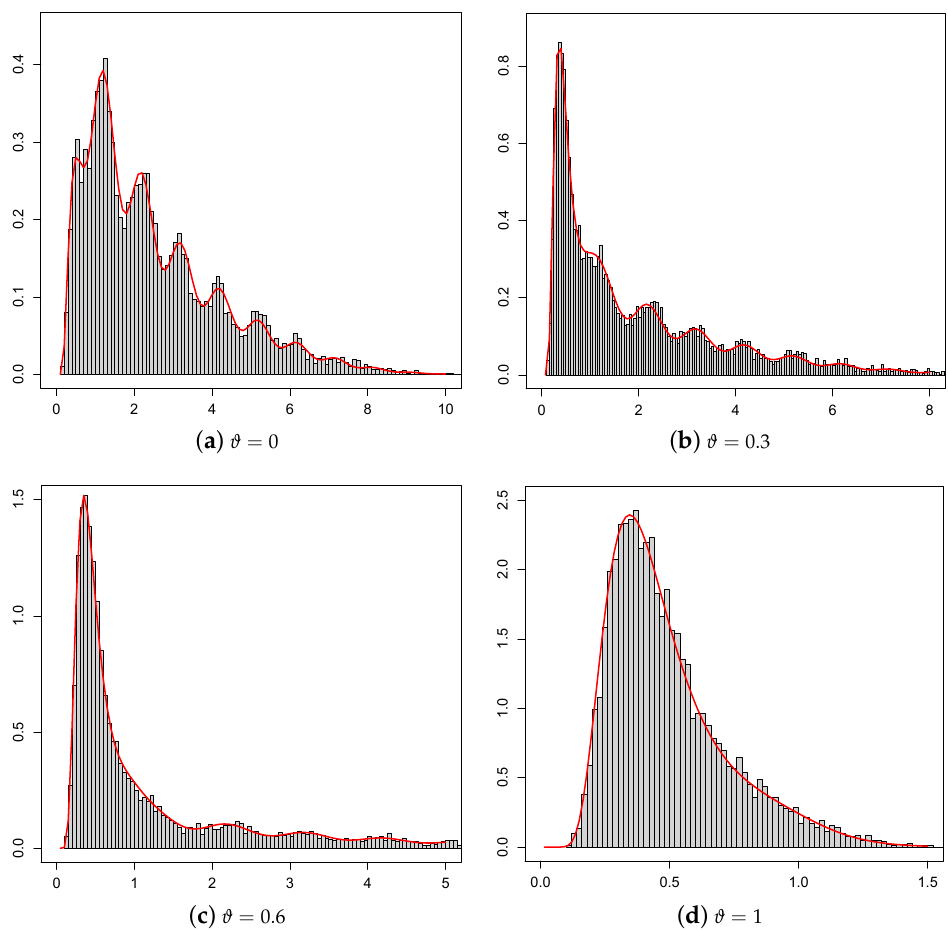
Figure 10. Histograms of FPT through the boundary (84) for Z ( t ) , having infinitesimal moments (81), are compared with the FPT densities (solid curve) in (85), with Ω ( t ) defined in (79), for ( y , τ ) = ( 0,0 ) , α = − 0.2, γ = 1.5, ν = 0.1, Q = 2, a 1 = − 1.2, a 2 =